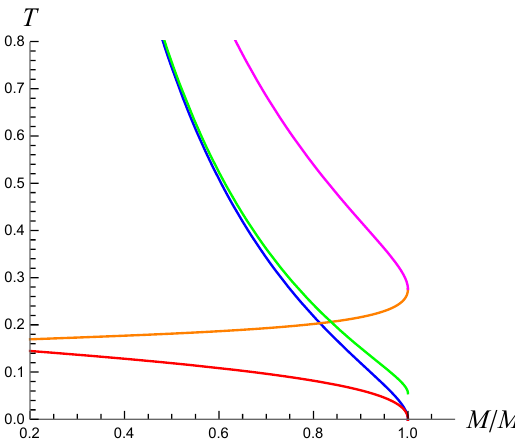
Figure 7 . Plot of the temperature as a function of mass M for ν = 1 / 3 . The blue and red curves correspond to temperatures T h and T c , respectively, while the magenta and orange curves correspond to ¯ T h and ¯ T c , respectively. The green curve represents the temperature of the Schwarzschild limit, where R 3 (cid:29) r h , coinciding with T h for small mass qSdS black